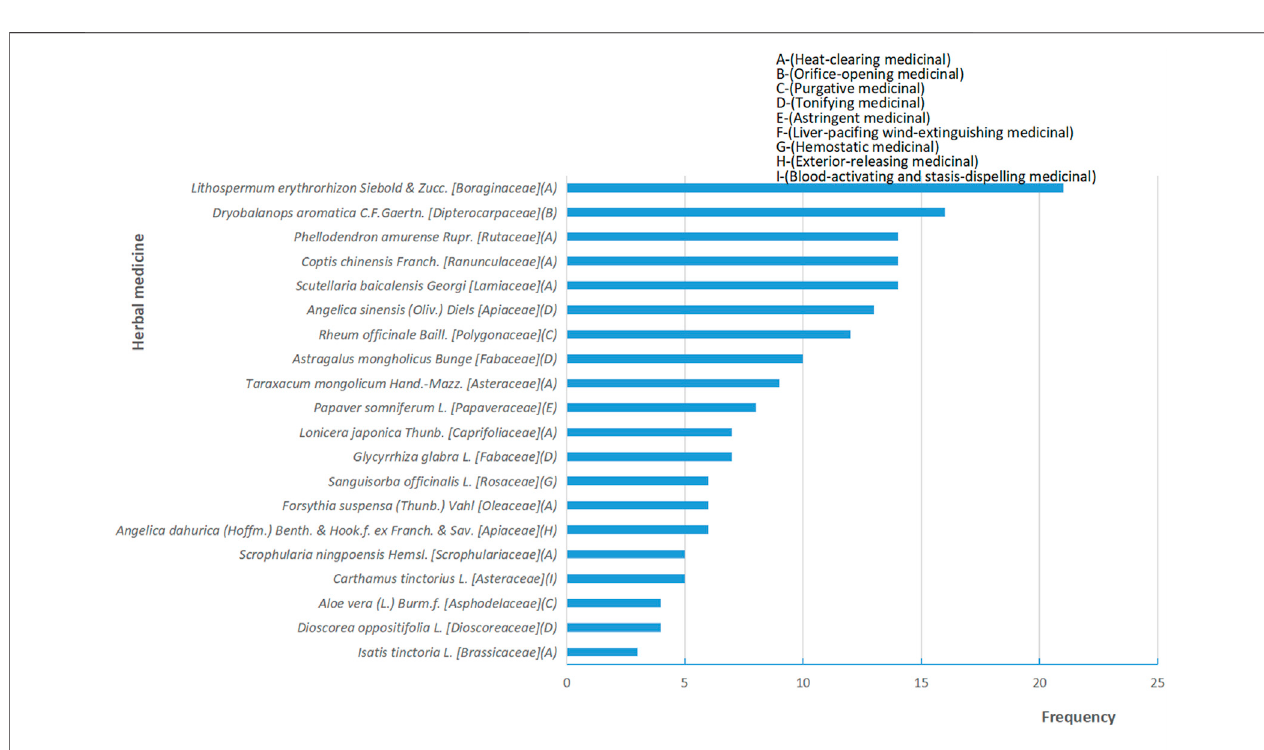
FIGURE 3 | Frequency distribution and functional classi fi cation of herbal medicine.